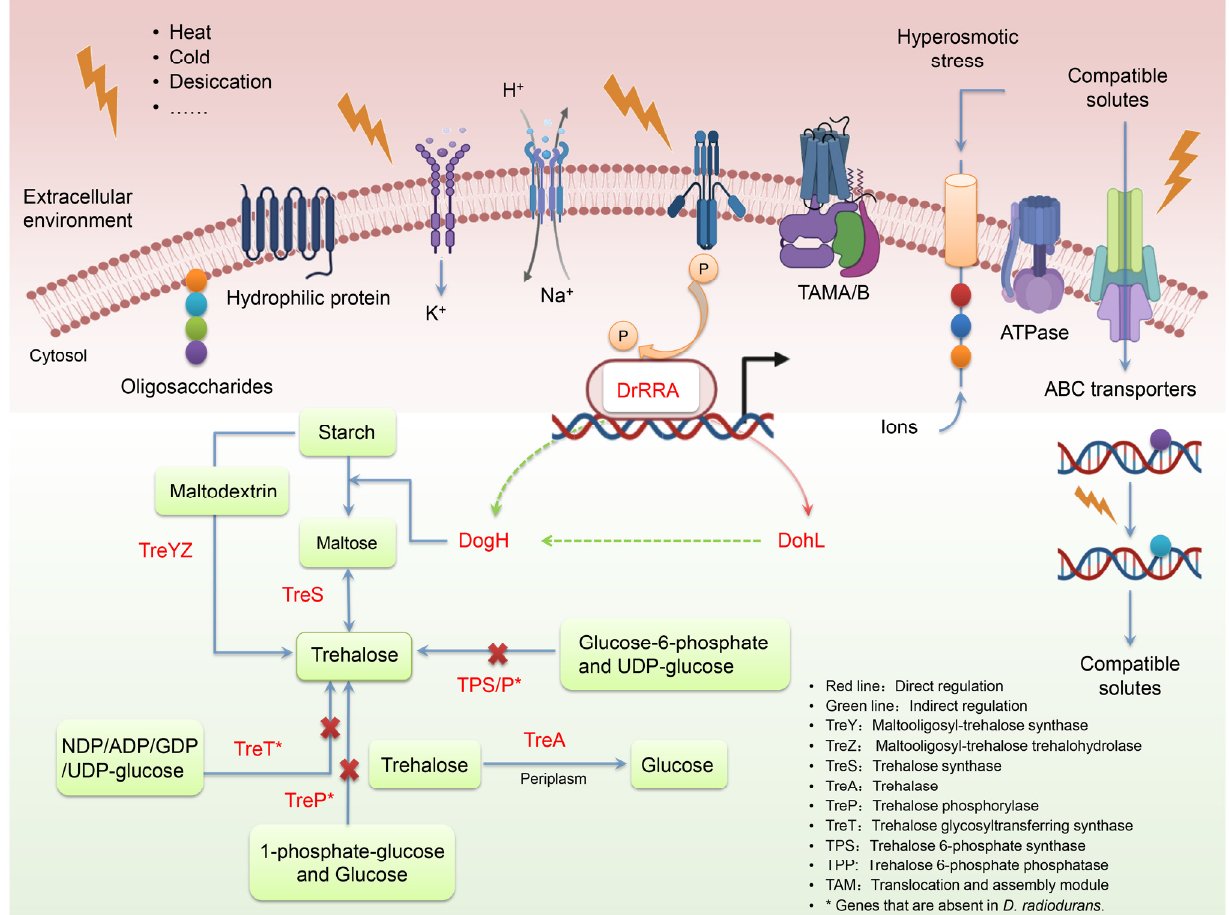
Figure 9. Overview of the osmoregulation mechanisms developed by D. radiodurans . Note: Ionic balance is maintained by transporting excessive ions out of the cell through ABC transporters; compatible solutes are accumulated to maintain the cytoplasmic activity of cells by either internal synthesis or transport from the surroundings through secondary carriers and ABC-type transporters, inducing hydrophilic protein expression to resist stressful situations.